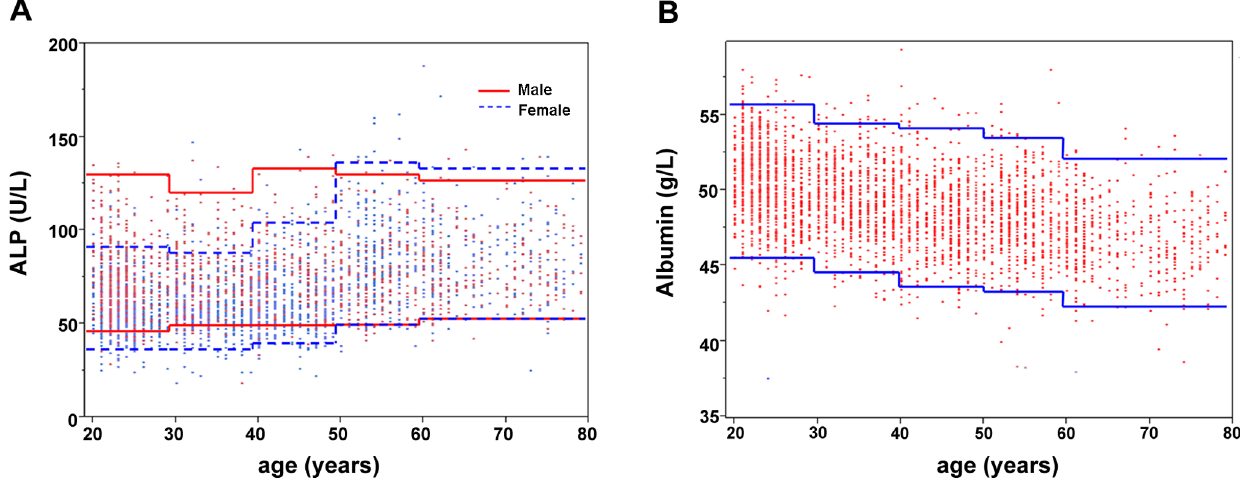
Figure 4. The scatterplots of ALP and albumin distributions as a function of age. The lines represent the lower (2.5 th ) and upper (97.5 th ) reference limits for different age groups in the scatterplots of ALP(A) and albumin(B) with